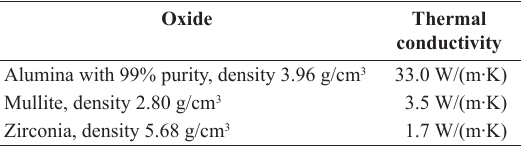
Table 6. Thermal conductivity of dense oxides. Oxide Thermal